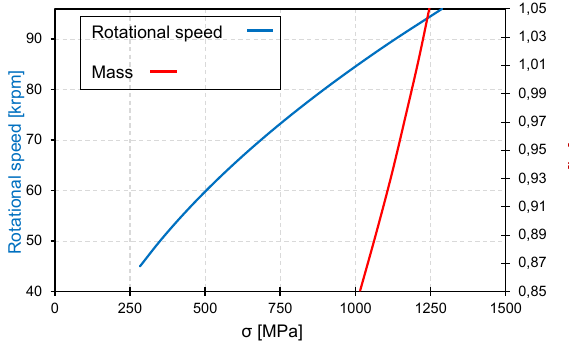
Figure 6: Rotational speed and mass of turbine disc vs. stress